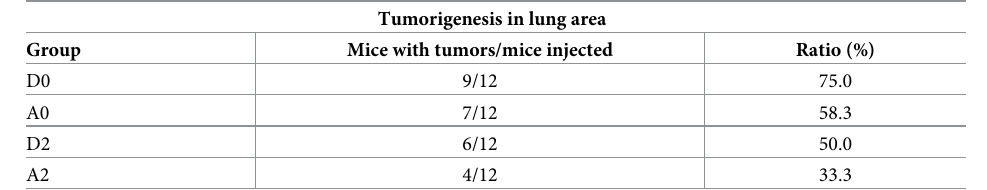
Table 1. Lung metastatic rate in